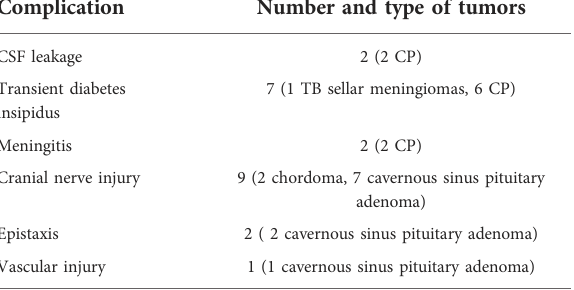
TABLE 2 Major postoperative complications and tumor categories.